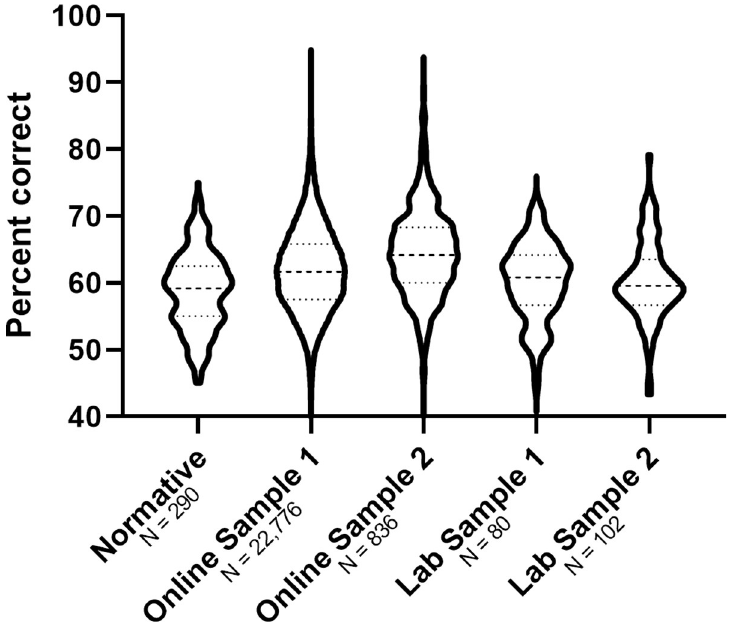
Fig 3. Comparison of the normative, lab and online samples on UNSW face test scores. The central dotted line indicates the mean and the lower and upper dotted lines indicate 25% and 75% percentiles, respectively.